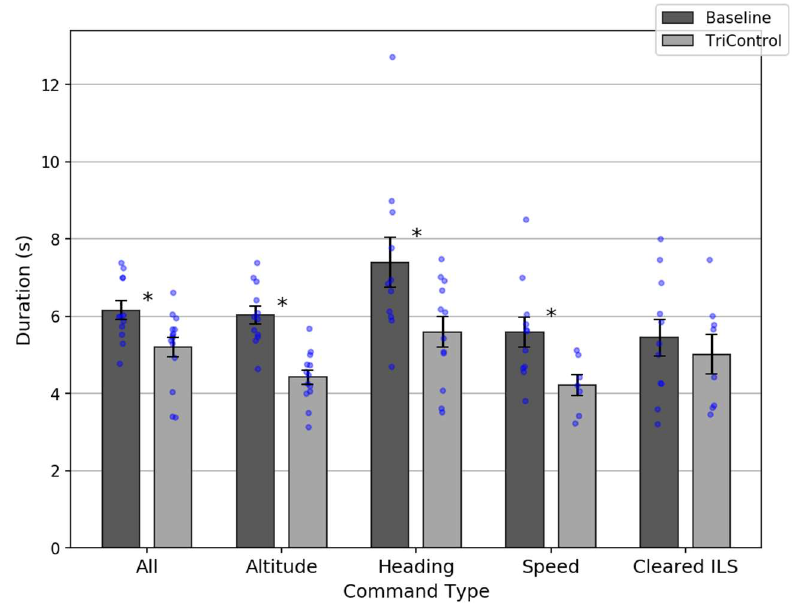
Figure 9. Baseline vs. TriControl second half uncorrected 75th percentile command duration. Error bars represent ±1 standard error of the mean. Blue dots represent individual controllers.